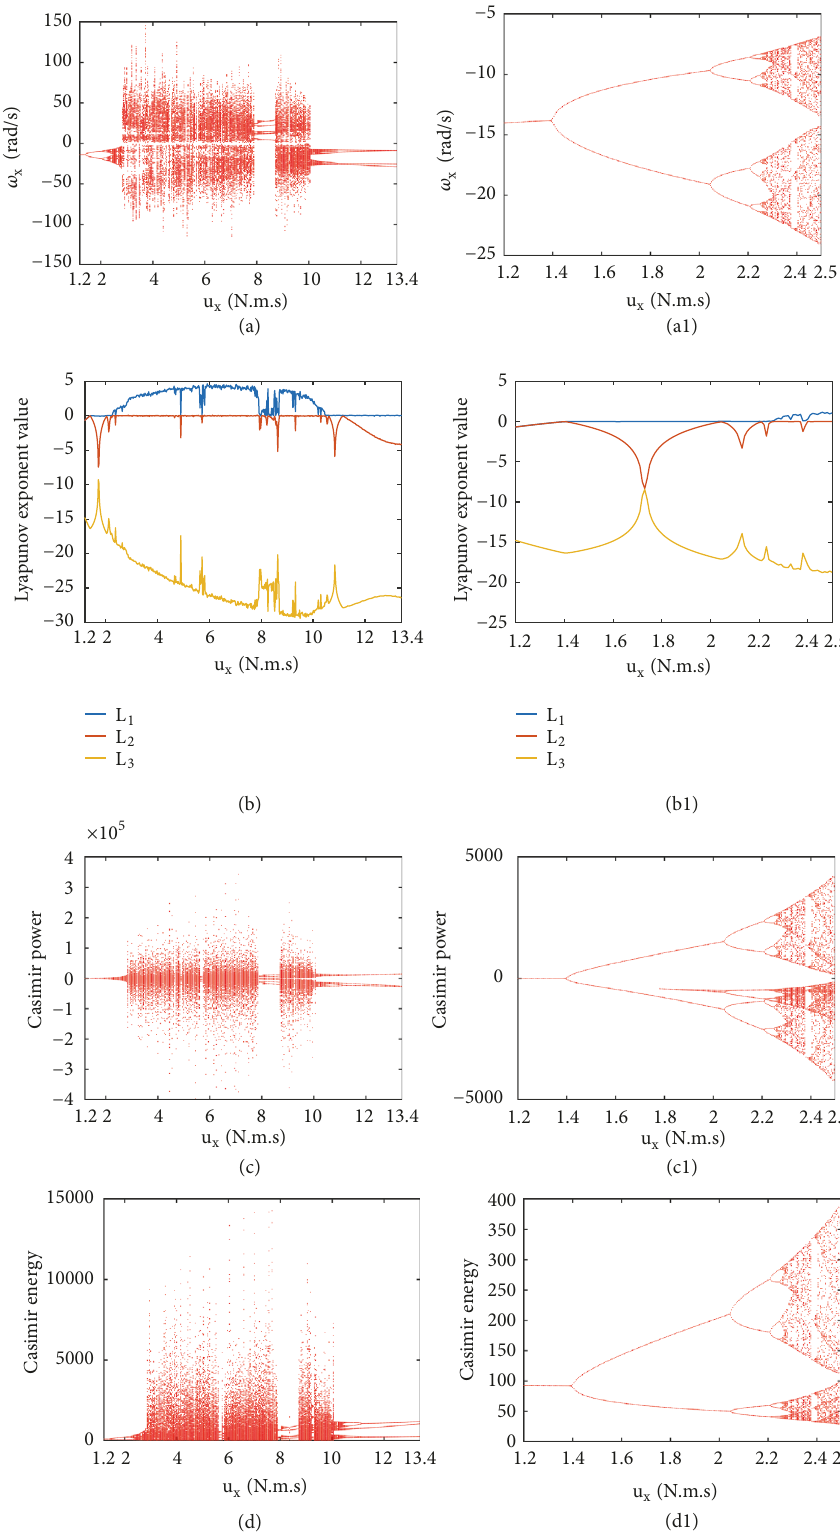
Figure 5: Bifurcation of the gyrostat system (4) with respect to 𝜇 𝑥 with 𝜇 𝑦 = 6.42 N . m . s , 𝜇 𝑧 = 5.8 N . m . s , 𝐿 𝑥 = 𝐿 𝑦 = 0, 𝐿 𝑧 = 22.8 N . m, (a) bifurcation diagram of state 𝜔 𝑥 , (b) Lyapunov exponent spectrum, (c) bifurcation of Casimir power, and (d) bifurcation of Casimir